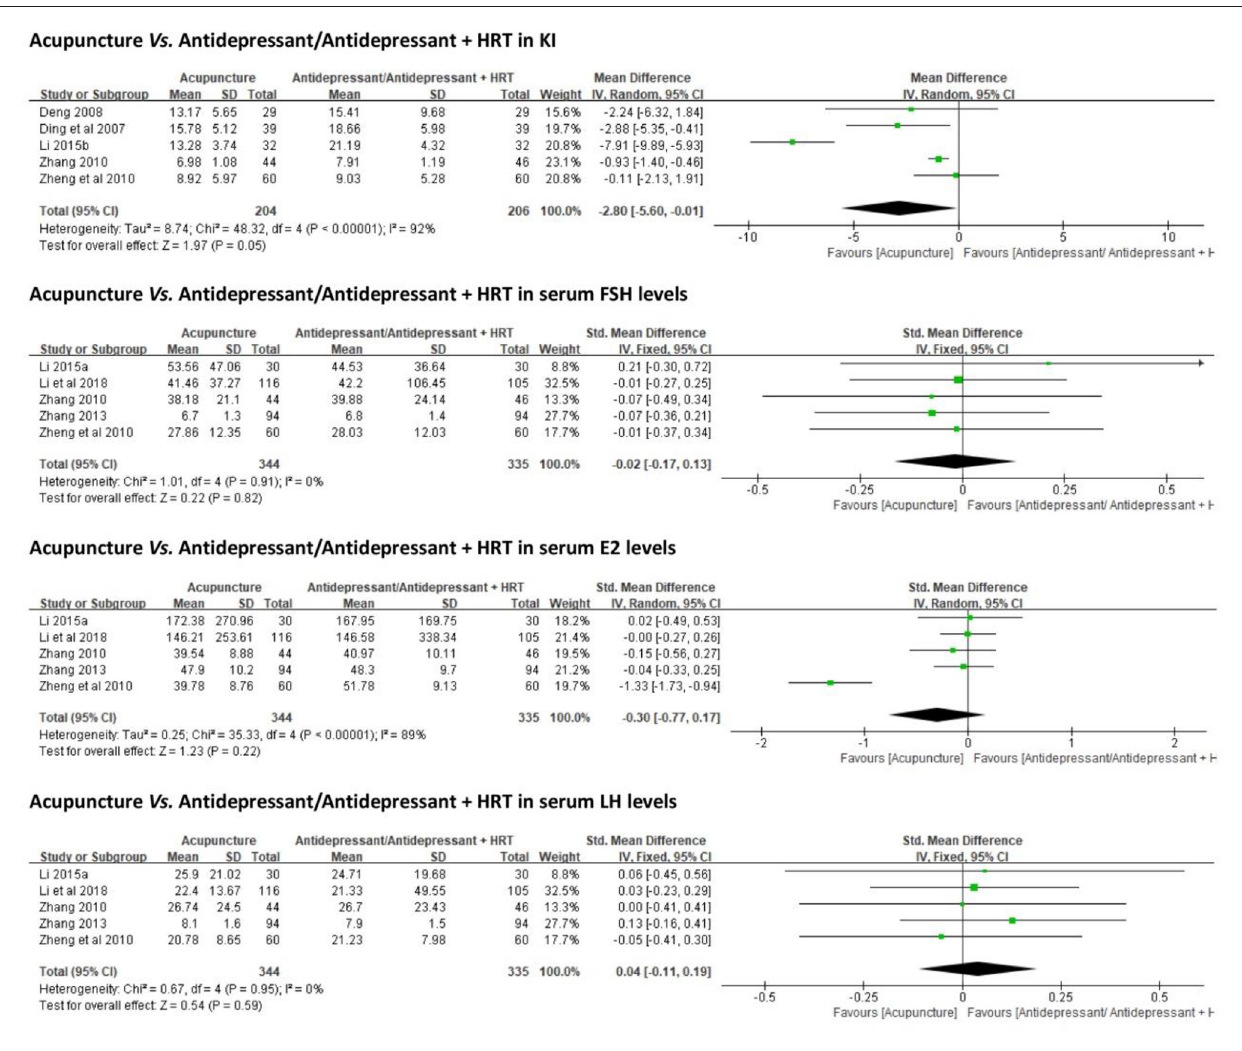
FIGURE 4 | Forest plots of acupuncture vs. antidepressant/antidepressant + HRT in KI and serum hormone levels. HRT, hormone replacement therapy; KI, Kupperman